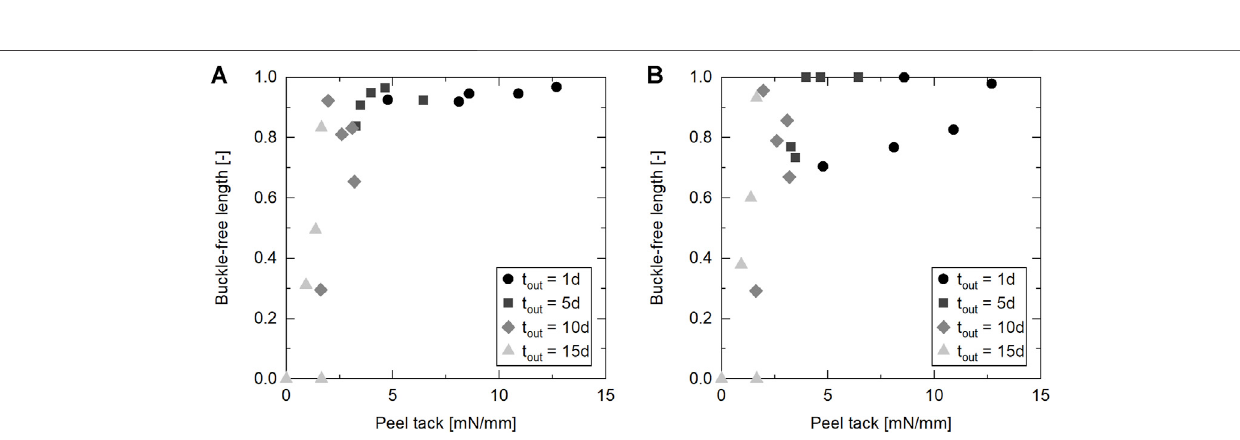
Frontiers in Materials |